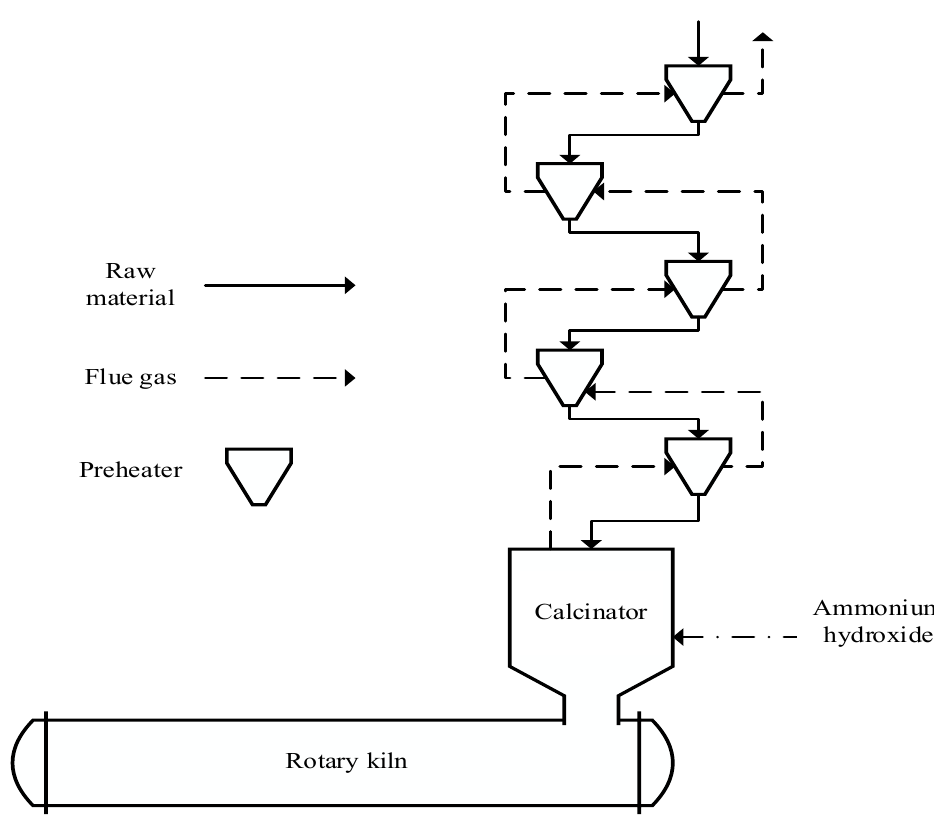
Figure 1. Part of the sketch for cement production.